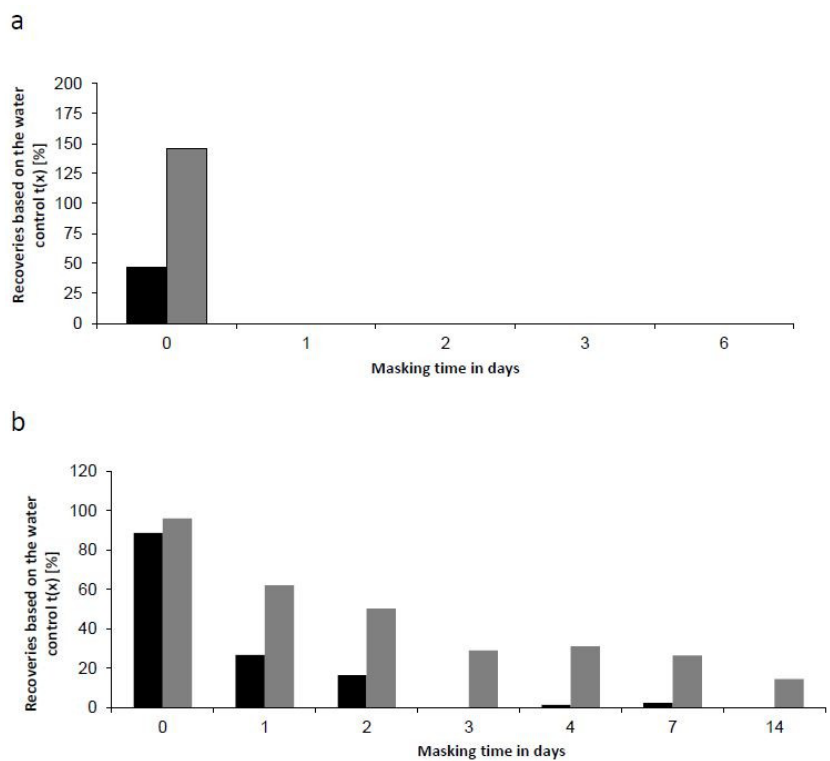
Figure 4. Differences in the masking behavior of purified endotoxins and NOEs. Recovery of endotoxin from E. coli O55:B5 is shown over incubation time. 100 EU/mL of gel-filtrated endotoxin (black bars) and sterile filtrated bacterial suspension (grey bars) were spiked into samples containing 10 mM sodium citrate and 0.05% (w/v) Polysorbate 20. The samples were incubated up to 14 days at RT ( a ) and 4 °C ( b ).